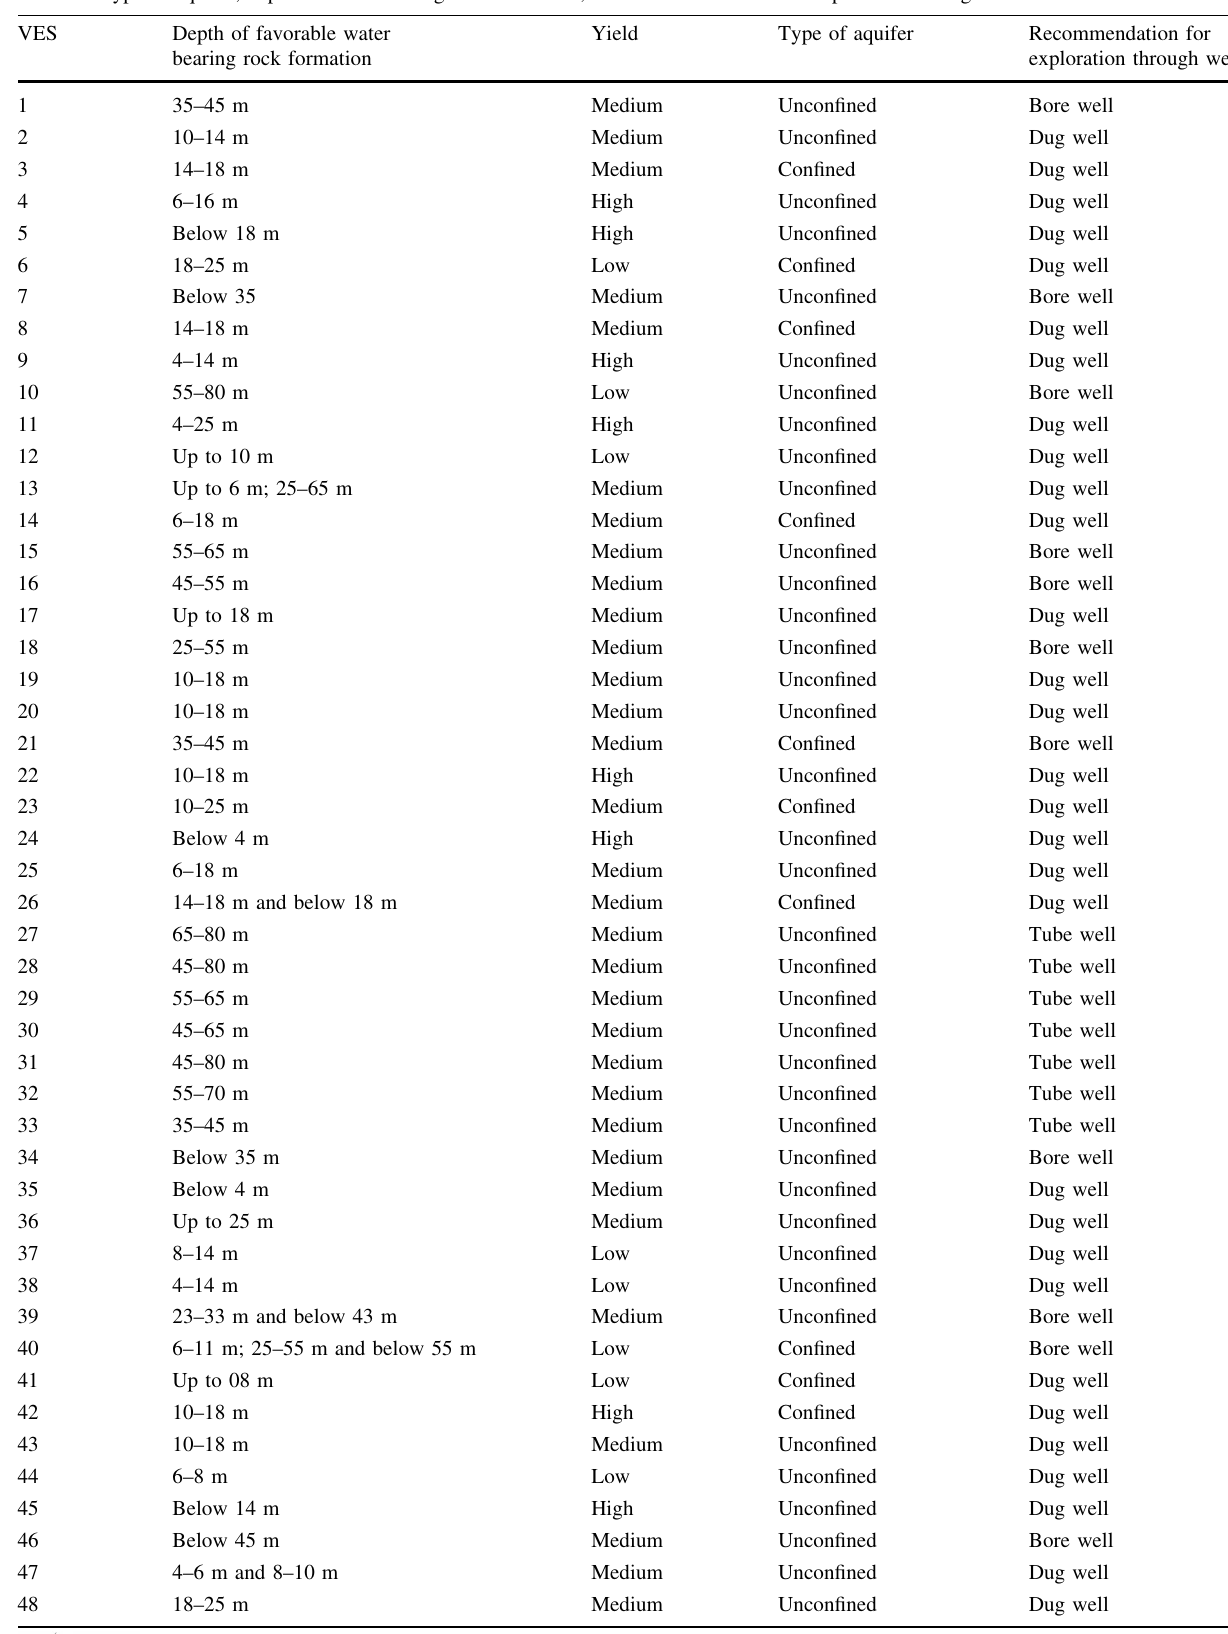
Table 3 Type of aquifer, depth of water bearing rock formation, and recommendation for exploration through